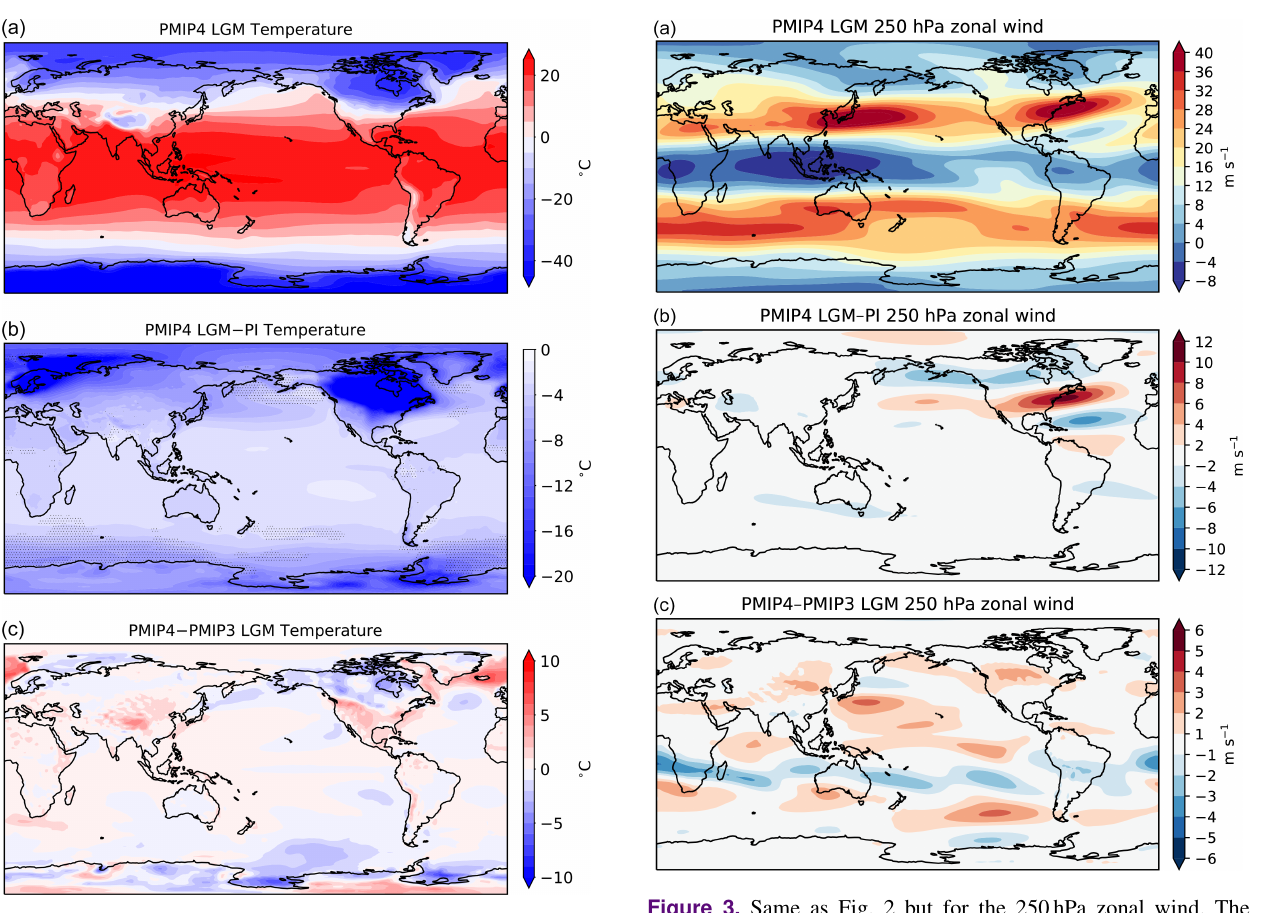
Figure 2. LGM mean annual temperature (in ◦ C) simulated by the ensemble of PMIP4 models (a) , LGM–PI mean annual temperature anomaly (in ◦ C) simulated by the same models (middle, where stip- pling shows where models do not agree on the sign of changes), difference between the PMIP4 and PMIP3 ensembles (in ◦ C, b ). The PMIP4 average is based on models listed in Table 1, except for iLOVECLIM simulations, which are at lower resolution. The PMIP3 average is based on all PMIP3 models, except the GISS- E2-p151 simulation, which did not use the PMIP3 ice sheet for its boundary conditions.